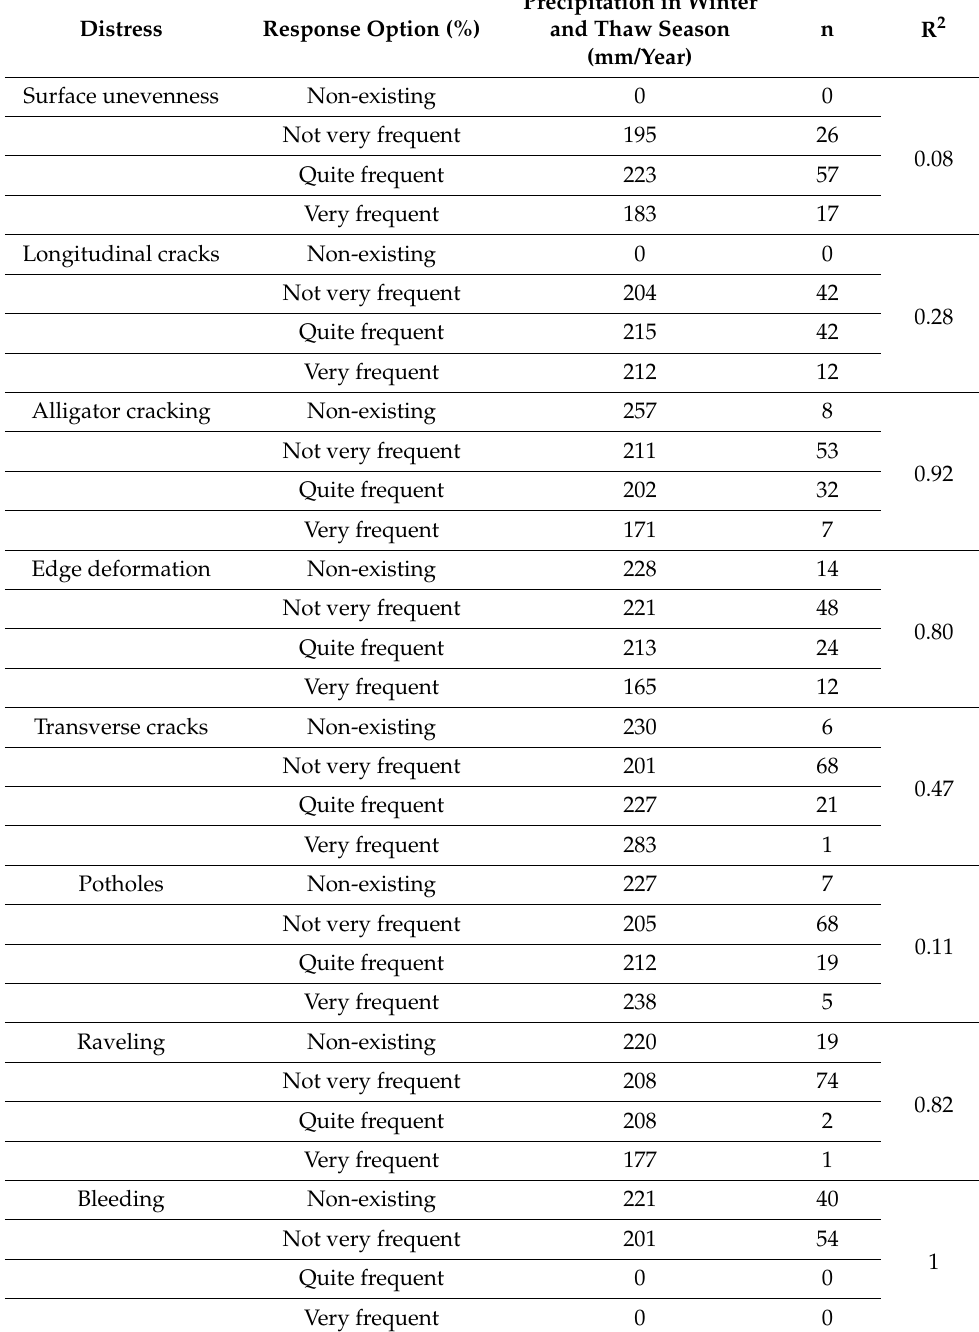
Table A2. The table shows the correlation between the stated distress modes and the mean average precipitation, according to SMHI, with respect to the answering options during winter and thaw seasons in 2000–2019. Bold R 2 values represent a strong correlation, as shown in Figure